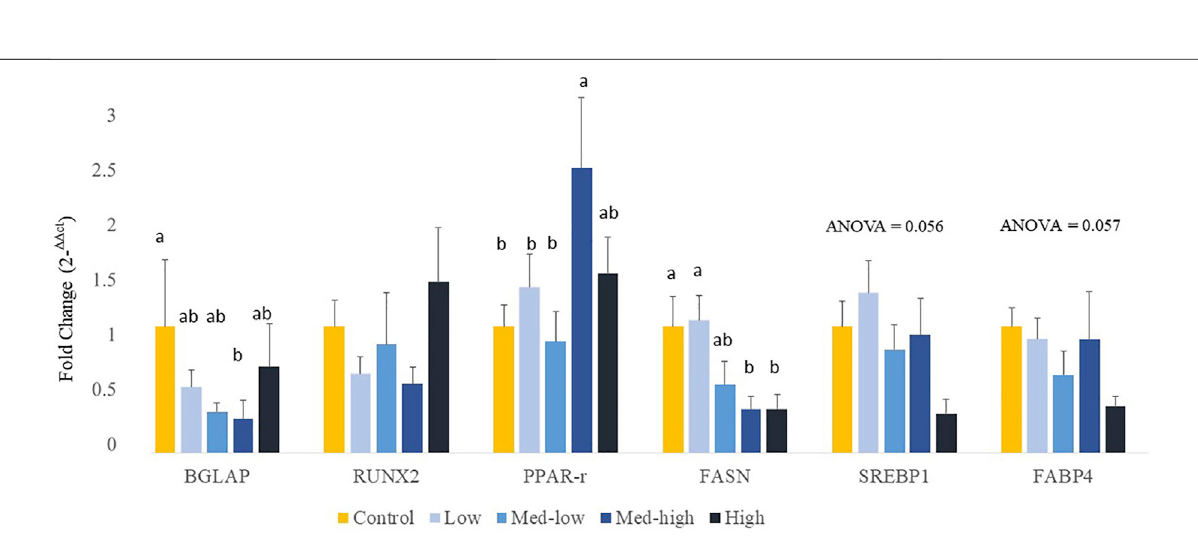
Eimeria oocysts ( Table 7 ; linear, p = 0.043, R 2 = 0.143). GSH content was signi fi cantly decreased by Eimeria infection and the lowest GSH content was observed in the Med-High group ( Table 7 ; ANOVA, p = 0.036). By comparing infected groups (Low, Med-low, Med-high, High) with the non-infected Control, a signi fi cant higher SOD activity ( p < 0.001) and numeric lower GSH content ( p = 0.091) were detected in pooled Eimeria -infected groups.